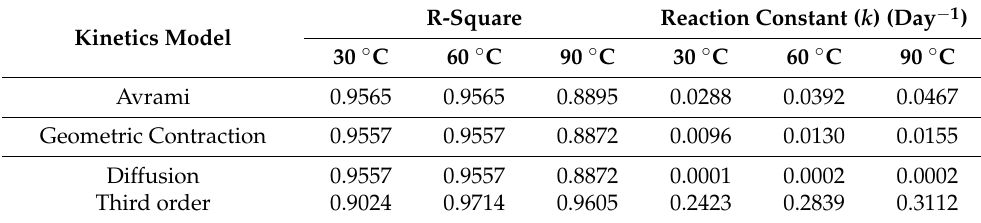
Table 6. The R-square and reaction constant values are generated by fitting the degree of reaction with the kinetic reaction